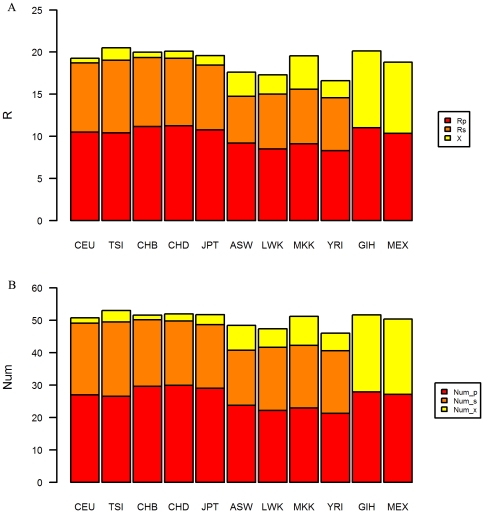
Proportions of components in mean genetic risk in human groups.In subplot A, Rp, Rs and X (subplot A) are the sums of harmful probabilities on population-shared, subpopulation-shared and group-specific SNPs, respectively. In subplot B, Num_p, Num_s and Num_x are the total numbers of mutations on population-shared, subpopulation-shared and group-specific SNPs, respectively.